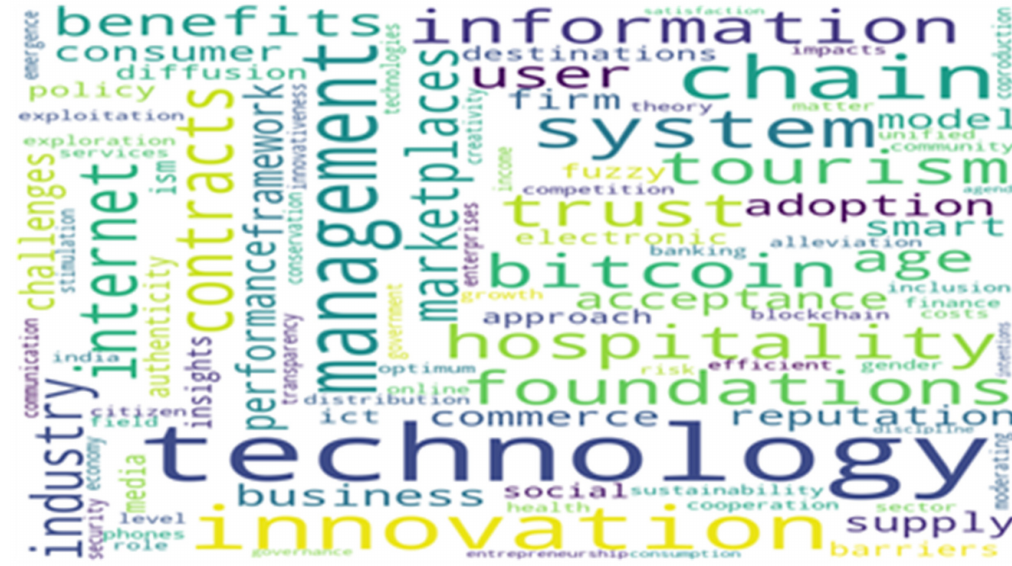
Figure 6. Word cloud for predicted words. Source: Authors’ analysis. RQ2: What high-frequency keywords are used in all extracted publications collected from Web of Science in their titles and